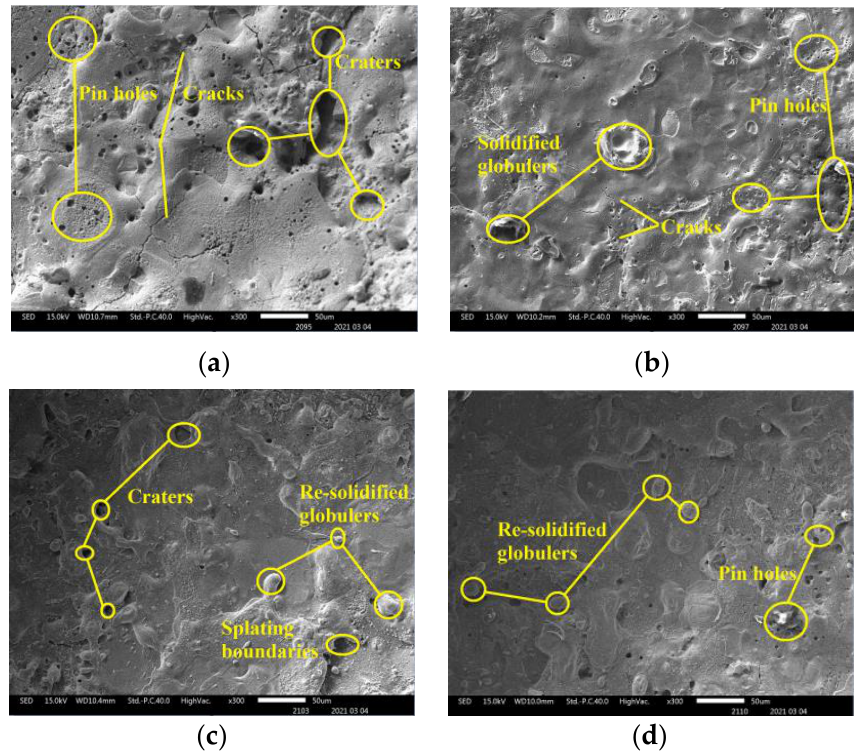
Figure 8. The surface of SS304 machined by different electrodes: ( a ) SS304; ( b ) TC4; ( c ) brass; ( d ) W80Cu20.